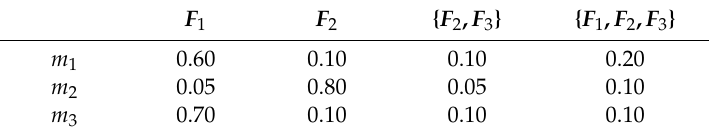
Table 7. The basic probability distribution of sensor data in fault diagnosis problem.